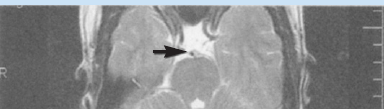
Fig. 2. Flow-related signal loss in the carotid and basillary arteries (T2 axial study of the brain).